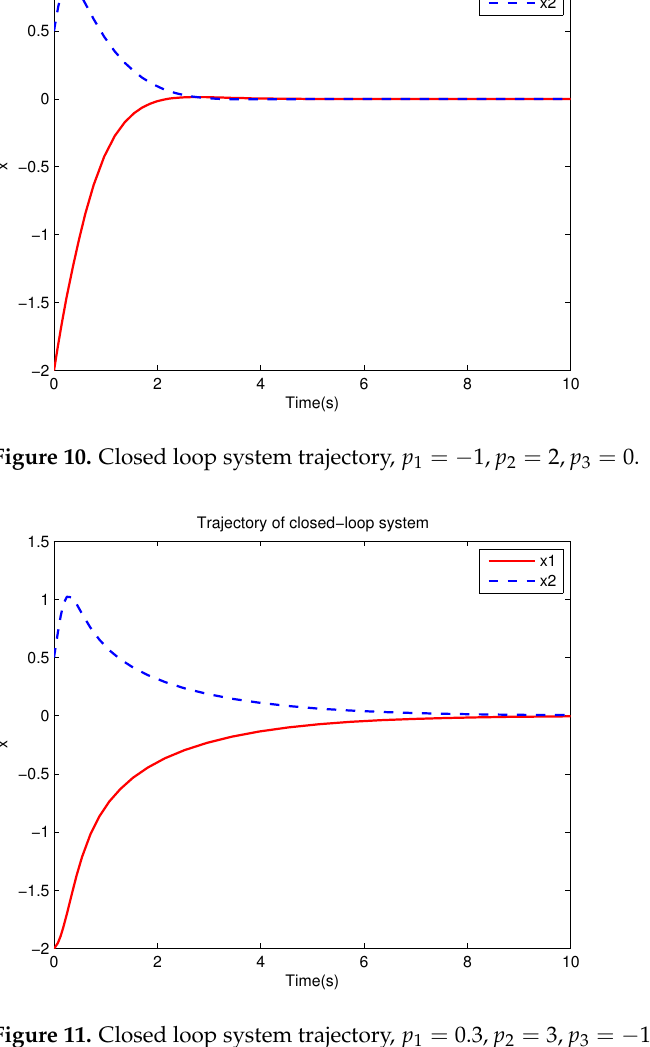
Figure 11. Closed loop system trajectory, p 1 = 0.3, p 2 = 3, p 3 = − 1.